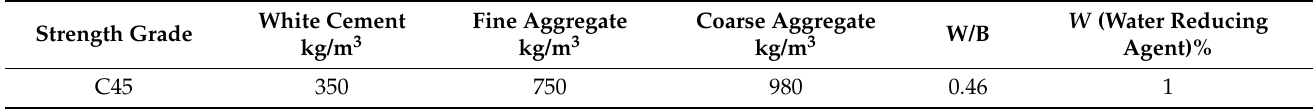
Table 2. Recycled concrete (RC) mixture